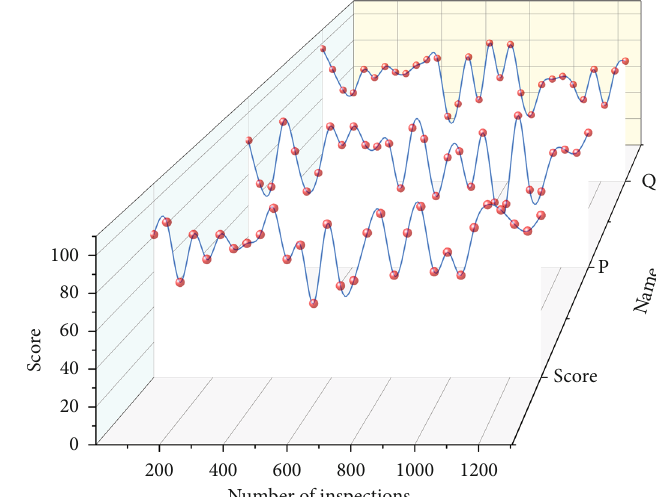
Figure 7: Overall class focus line graph.